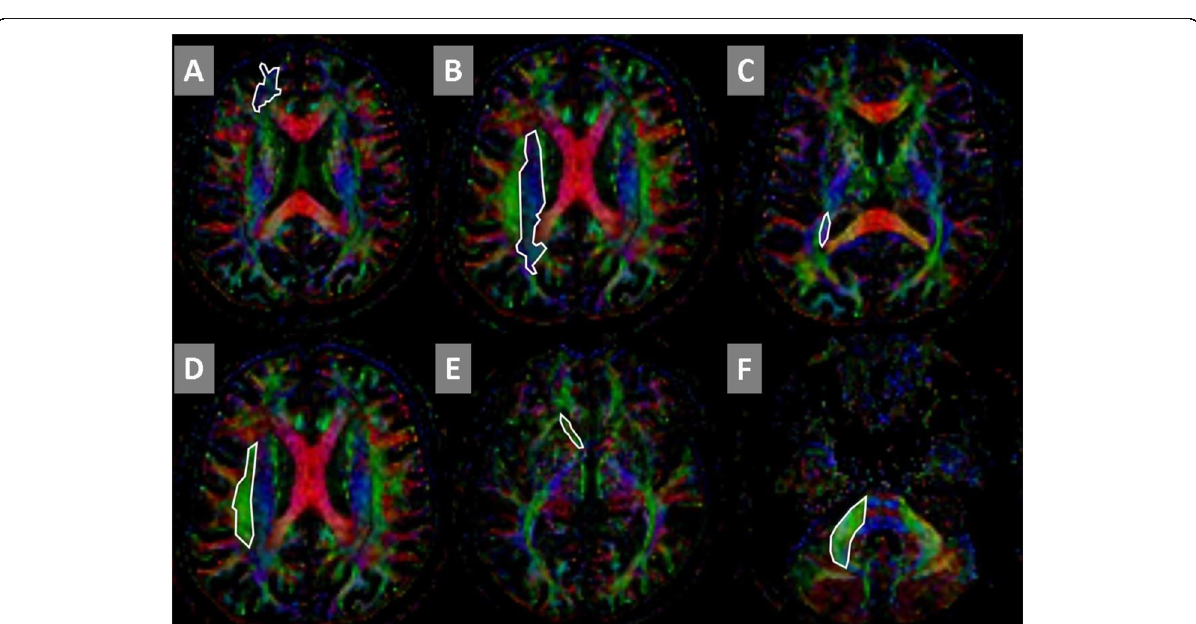
Fig. 1 Axial color map images with a drawing showing ROIs used for different tracts. ( A ) anterior corona radiata, ( B ) superior corona radiata, ( C ) posterior corona radiate, ( D ) superior longitudinal fasciculus, ( E ) anterior thalamic radiation, ( F ) middle cerebellar